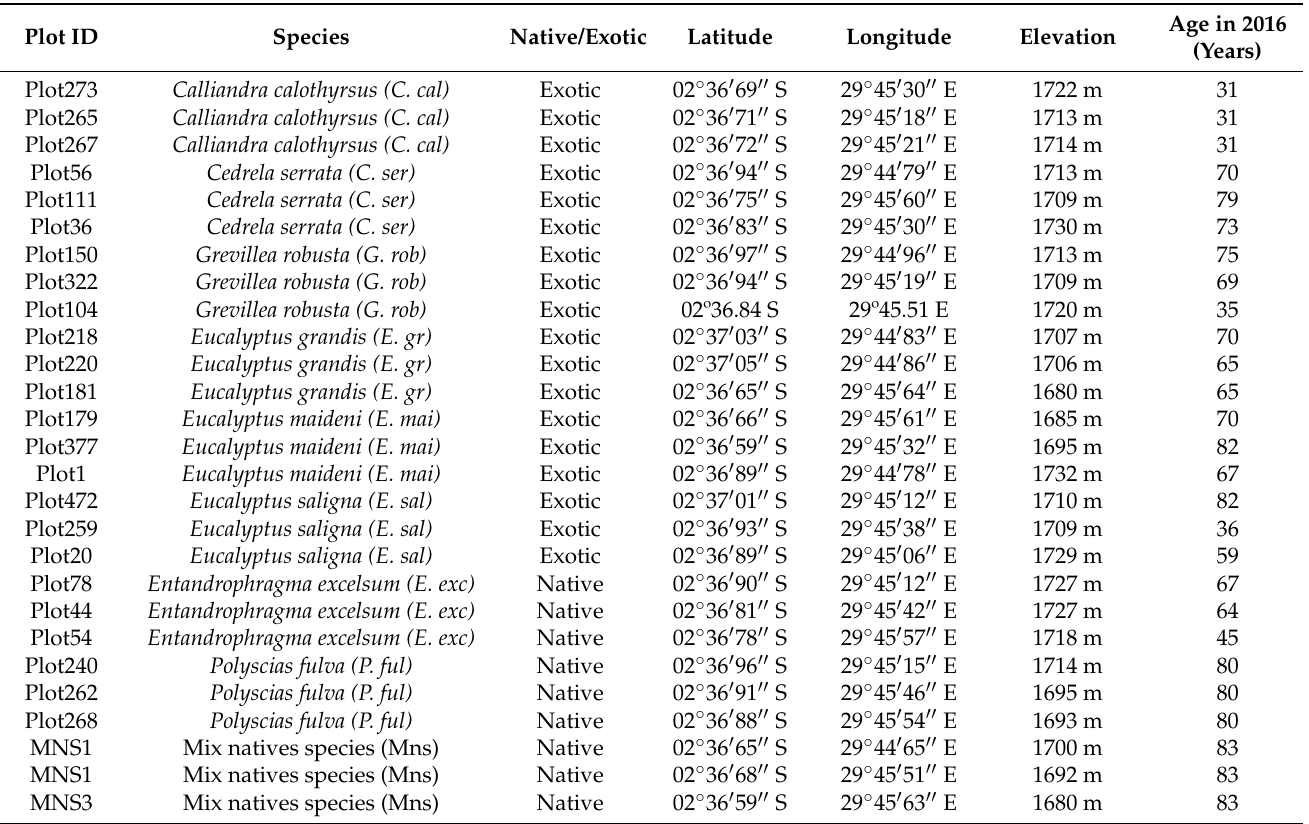
Table A1. Selected study plots in the Arboretum of Ruhande, Rwanda. (Rwibasira et al., Long-term effect of forest plantation species on soil chemical properties in Southern Rwanda).